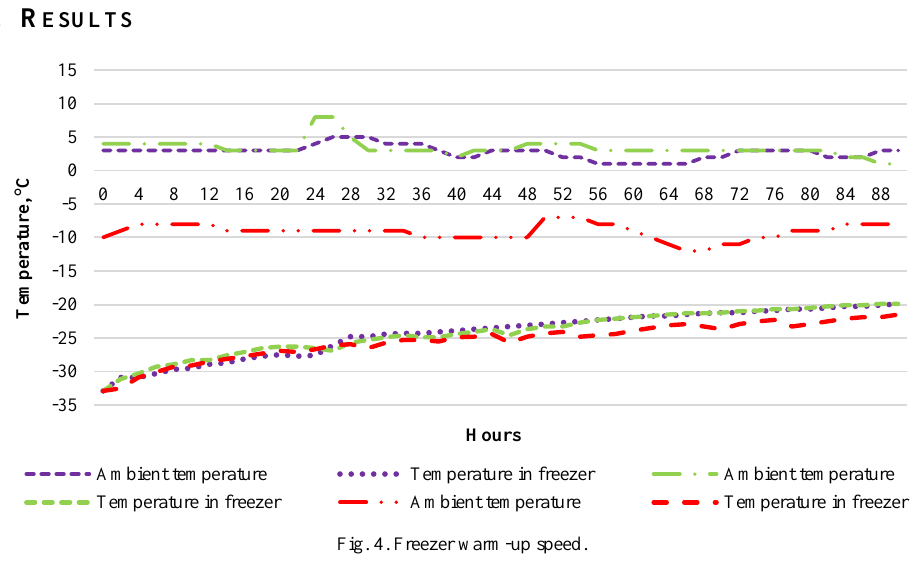
Fig. 4. Freezer warm-up